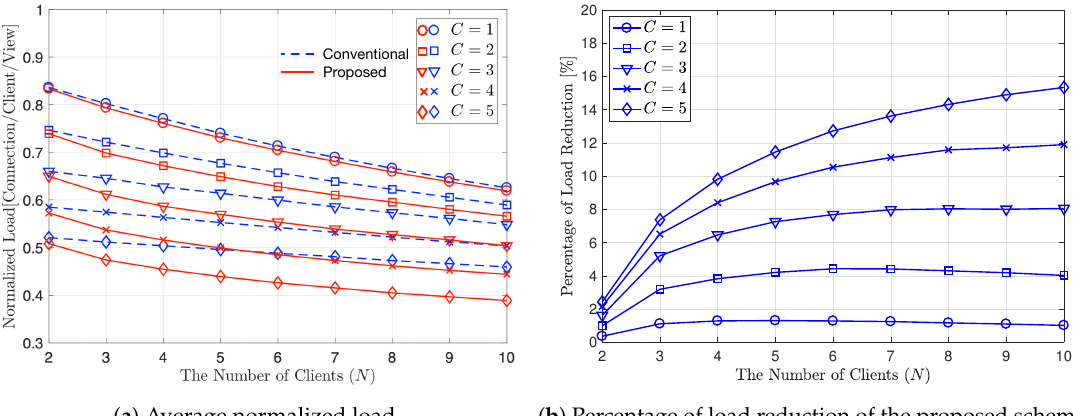
Figure 7. Average normalized load and percentage of load reduction of the proposed scheme for varying N . V = 20, C 1,2,3,4,5 , and α = ∈ { }